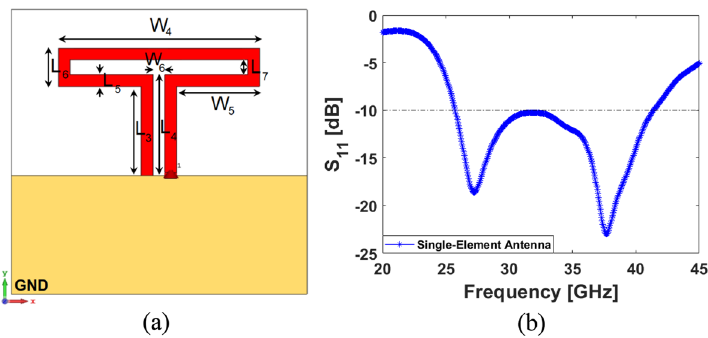
Figure 24. ( a ) Single-element loop resonator configuration and ( b ) its S 11